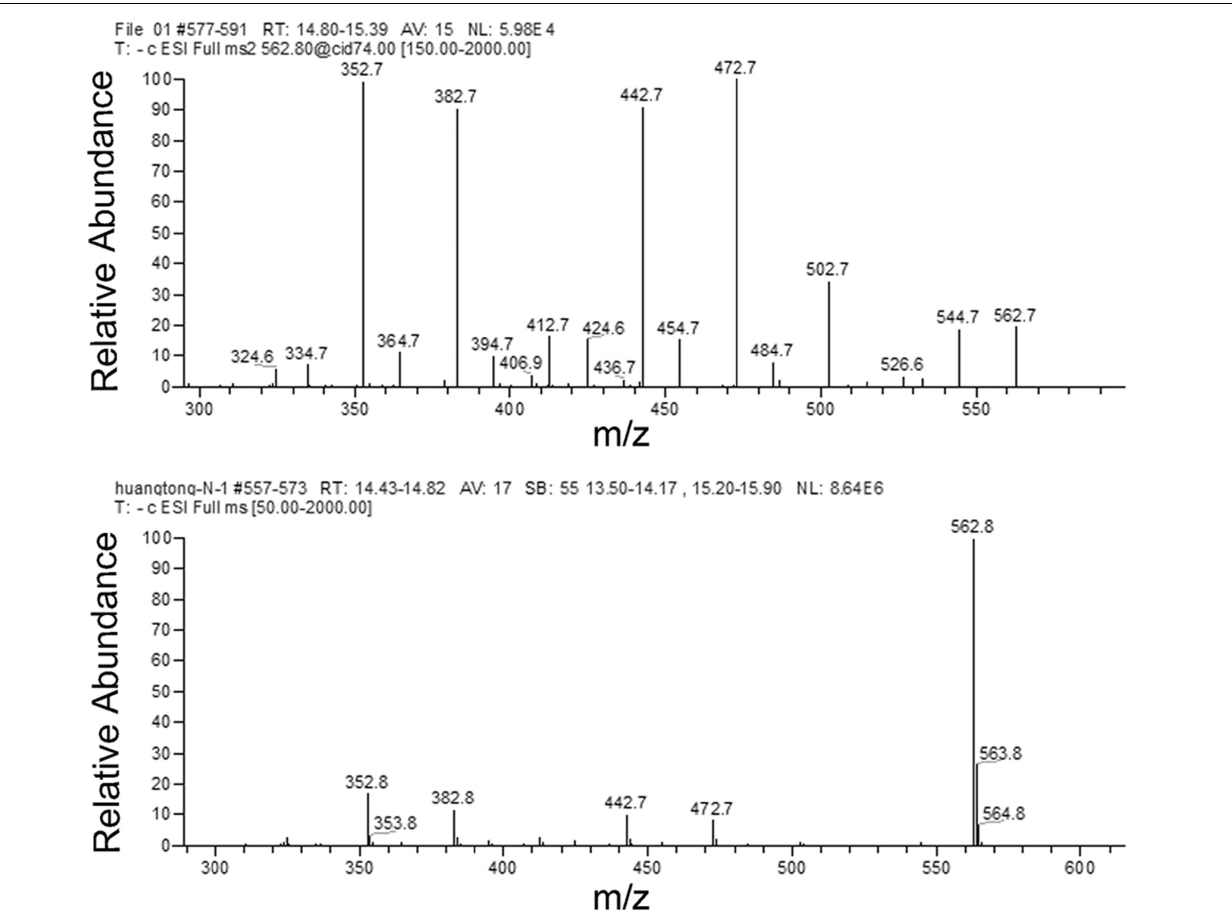
FIGURE 3 | MS/MS of the pseudomolecular ions [M-H] - of Peak 1 related